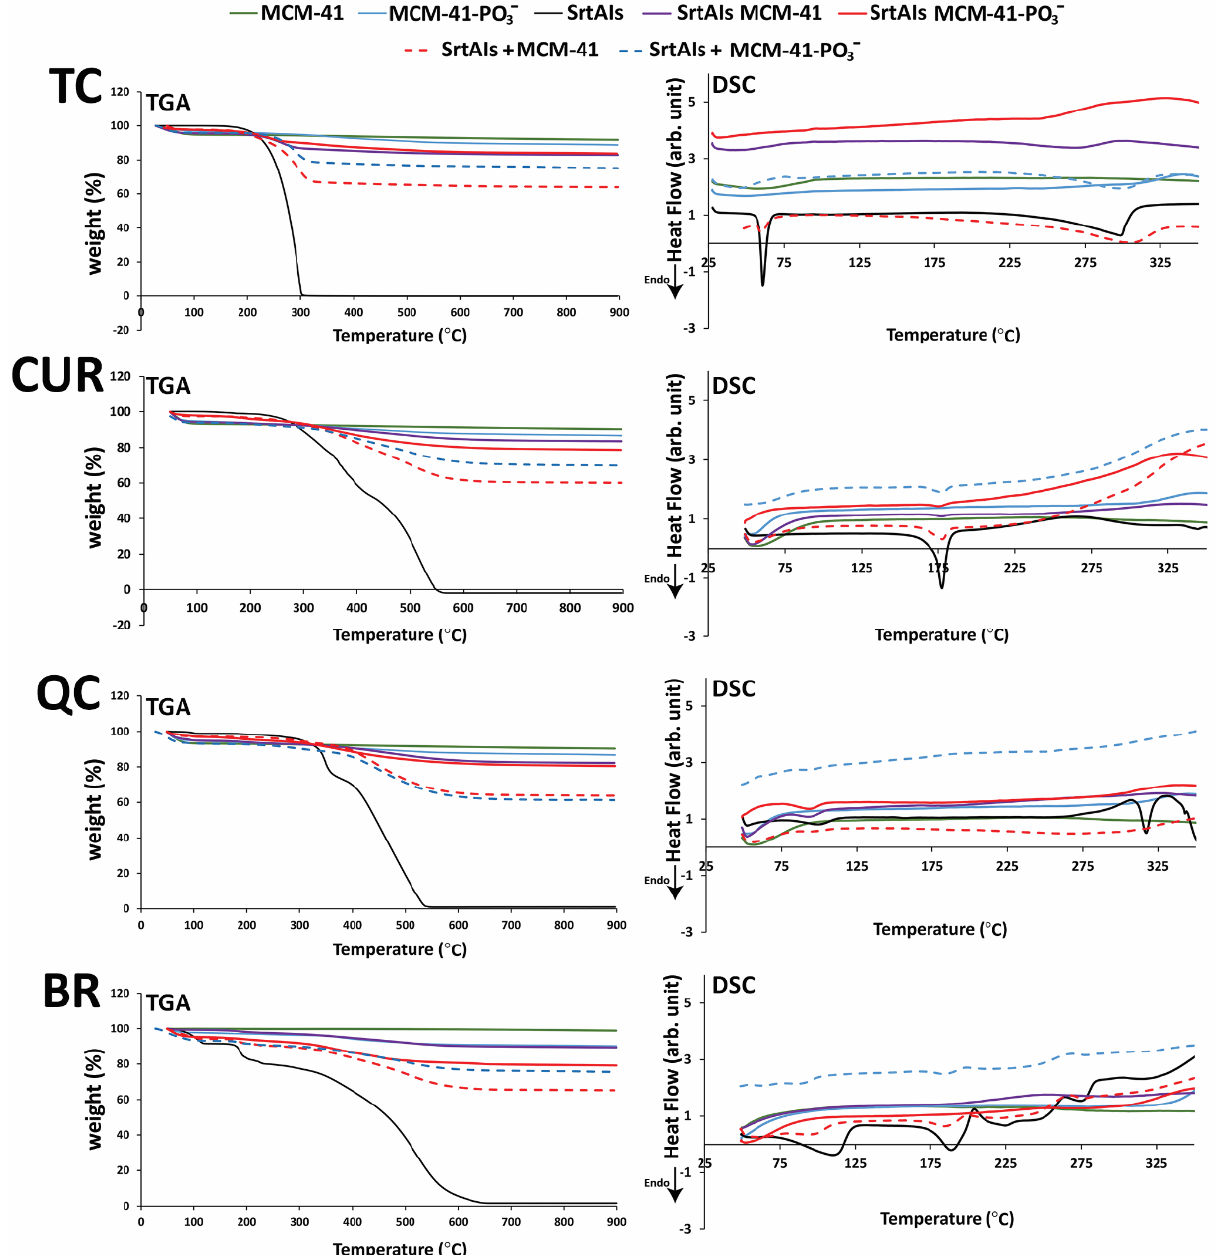
Figure 3. Thermogravimetric analysis (TGA) and differential scanning calorimetry (DSC) for SrtAIs (TC, CUR, QC, and BR), and MSNs (MCM-41 and MCM-41-PO 3 − ) alone, loaded with SrtAIs, or physical mixtures with SrtAIs. “+” refers to physical mixture and ‘arb. unit’ indicates arbitrary units.